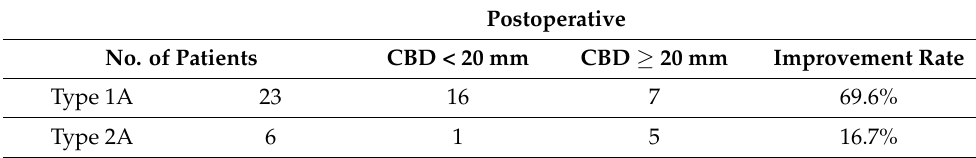
Table 5. Number of patients with improved CM after surgery. CBD, coronal balance distance.